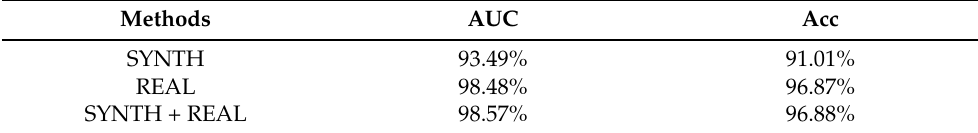
Table 4. Segmentation performance, using the single-step method, on the DRIVE dataset.